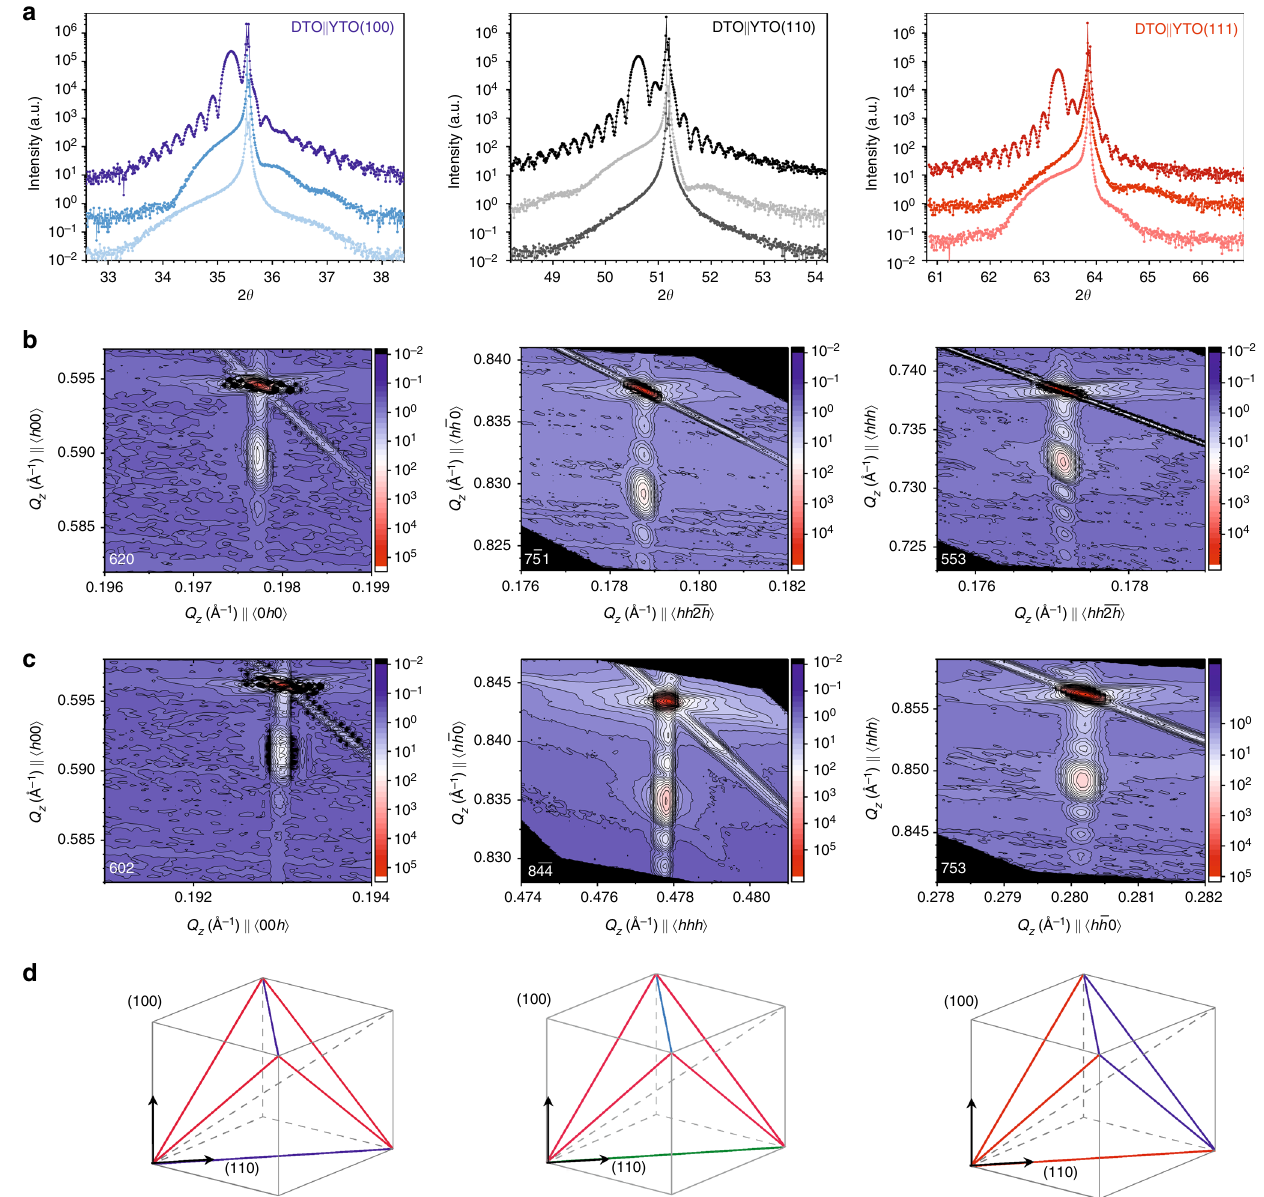
Fig. 2 Epitaxy and compressive strain. Colour code: DTO||YTO( hkl ) with ( hkl ) = (100) (blue), ( hkl ) = (110) (black), ( hkl ) = (111) (red). Each column reports data related to the same ( hkl ) as labelled in the fi rst row. a High-resolution 2 ϑ (cid:1) ω scans showing, from left to right, the (400), (440) and (444) re fl ections for different fi lm thicknesses. b , c Room temperature high-resolution X-ray powder diffraction (XRD) reciprocal space maps (RMS) for the thickest sample of each series. Here, the two orthogonal Q x are the components of the reciprocal space vector aligned with the substrate in-plane edges. These RMS con fi rm the fi lm is high quality, fully epitaxial, and fully strained along the two in-plane orientations. d Schematics of the Dy sub-lattice are shown, where the tetrahedra edges depict the Dy – Dy distances. In the pyrochlore cubic structure these are all identical. In each strained DTO||YTO( hkl ) fi lm, a different distortion is realised. Here, different colours represent different Dy – Dy distances (values are reported in Table 2). DTO Dy 2 Ti 2 O 7 , YTO Y 2 Ti 2 O orientation are coincident for T > 0.75 K, whereas at lower that certain small features described below (hysteresis) were not as temperature each set of samples behaves differently. clearly seen, possibly due to the dif fi culties in quantitatively For 44DTO||YTO(110) and 60DTO||YTO(111) (Fig. 3b, c, separating the contribution of the active material (DTO) from that respectively), a small hysteresis loop opens up at low enough of the substrate (YTO) for such thin layers. temperatures, below T = 0.75 K. During cooling, a small but clear For each series of samples, the magnetic speci fi c heat, C M , divided by temperature is plotted vs. temperature in Fig. 3. A bulk and reproducible discontinuity is observed at T = 0.510(2) K single crystal DTO has also been measured and reported in Fig. 3, (44DTO||YTO(110)) and T = 0.520(2)K (60DTO||YTO(111)). In for comparison. The behaviour of all thin fi lms is close to that of both samples, the width of the hysteresis loop does not vary for bulk spin ice at T > 2 K, but starts to deviate from it at lower repetitive cycles. In contrast, for 44DTO||YTO(100), correspond- temperatures, as previously reported 34 . Furthermore, as shown in ing to Fig. 3a, data measured during cooling and heating do not Fig. 3d, curves for samples grown along different crystallographic show any hysteresis or discontinuity. In the Supplementary